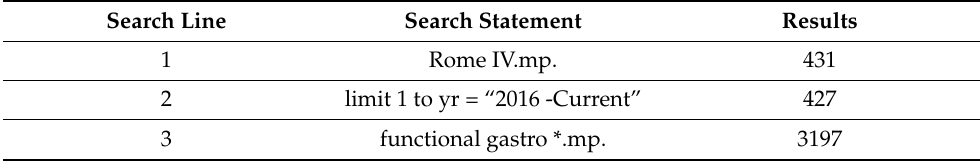
Figure S2: Comparison of overall percentage prevalence in each age group experiencing at least one FGID (*: outlier). Table S1: Risk of bias assessment for included articles, Checklist S1:PRISMA item